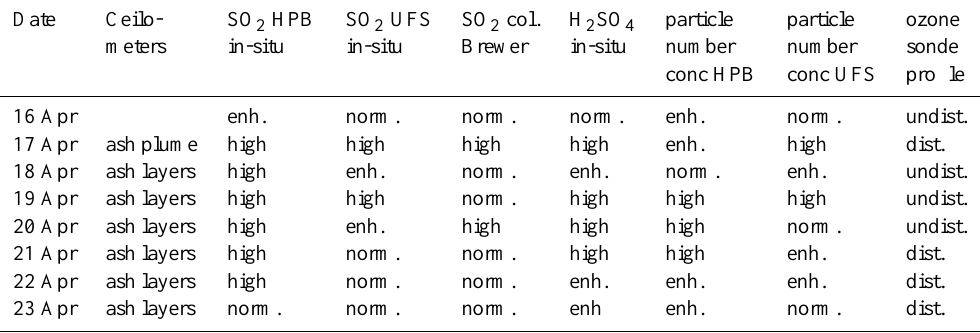
Table 1. Measured aerosol quantities and trace species at HPB and UFS between 16 and 23 April (norm.=normal, high, enh.=enhanced, dist.=disturbed,